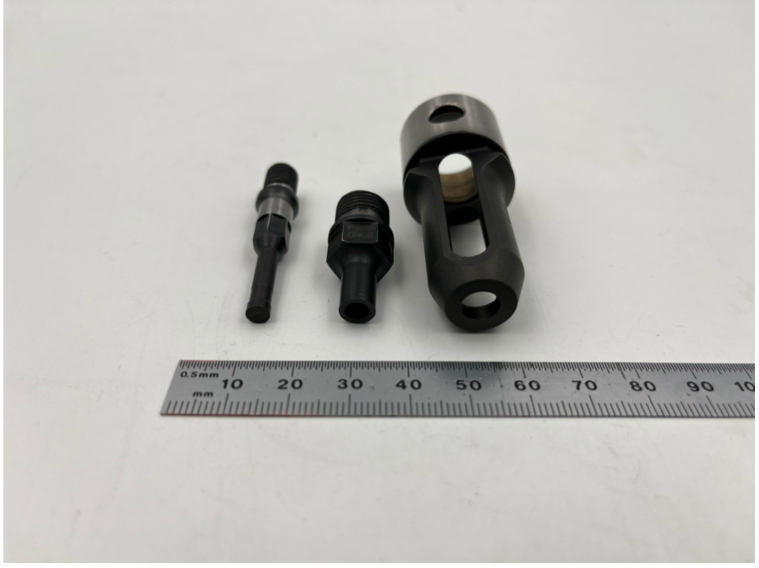
Figure 2. RFSSW tooling, including a pin ( left ), shoulder ( center ), and clamping ring ( right ). The experiment is completed in two modes: (1) volumetric and (2)